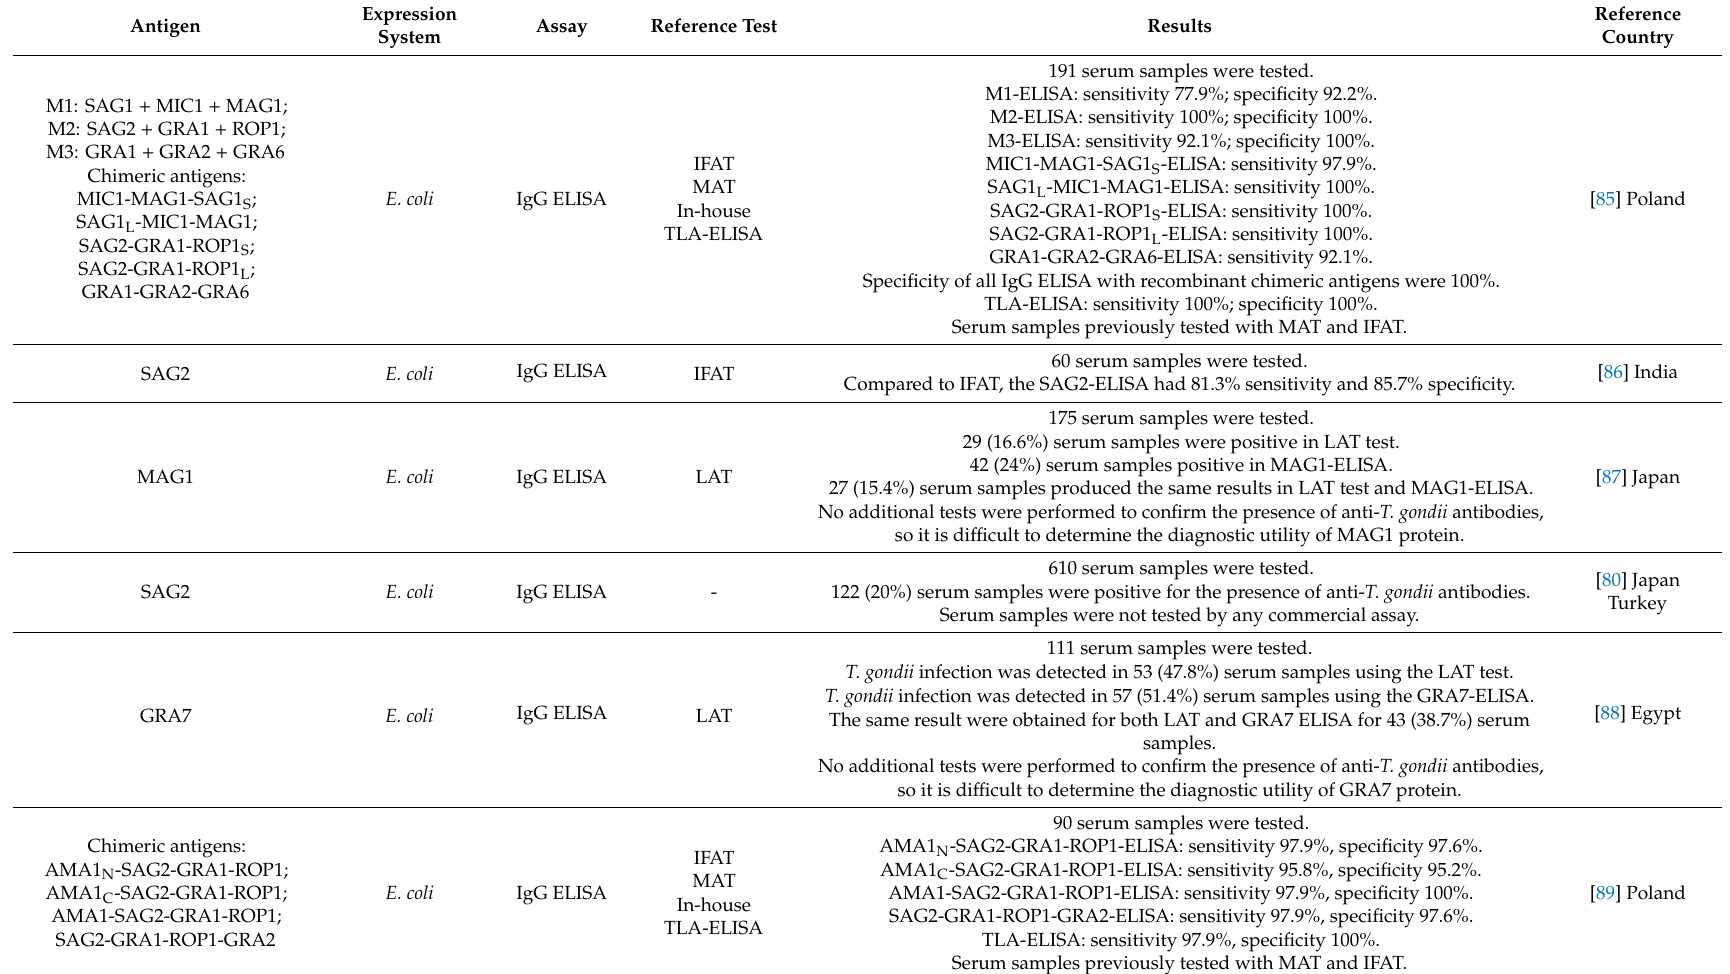
Explanation of abbreviations: SA—soluble somatic